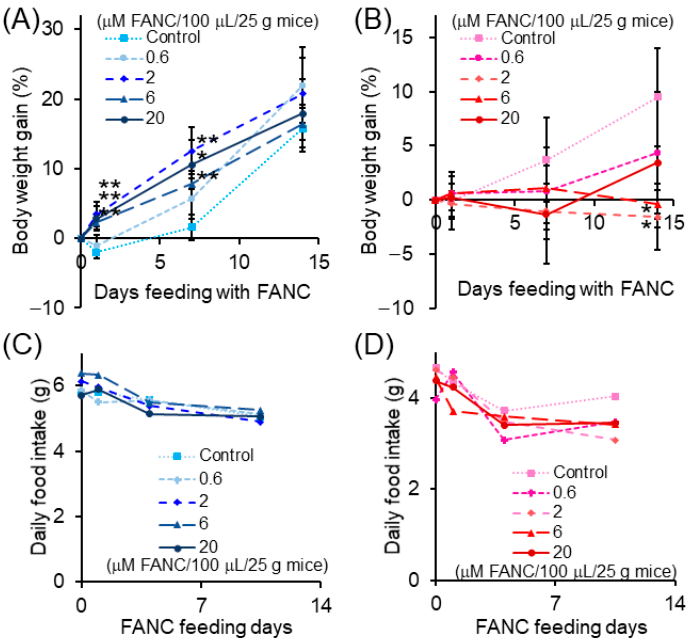
Figure 4. Body weight gain and daily food intake of ICR mice with daily feeding of FANC. Body weight gain of ( A ) male and ( B ) female mice. ( C ) Male and ( D ) female mice’s daily food intake was calculated from day 0–1, day 1–7, and day 7–14 using one mouse. Data are expressed as the mean ± SD ( n = 5). * p < 0.01, ** p < 0.001, significantly different to control.